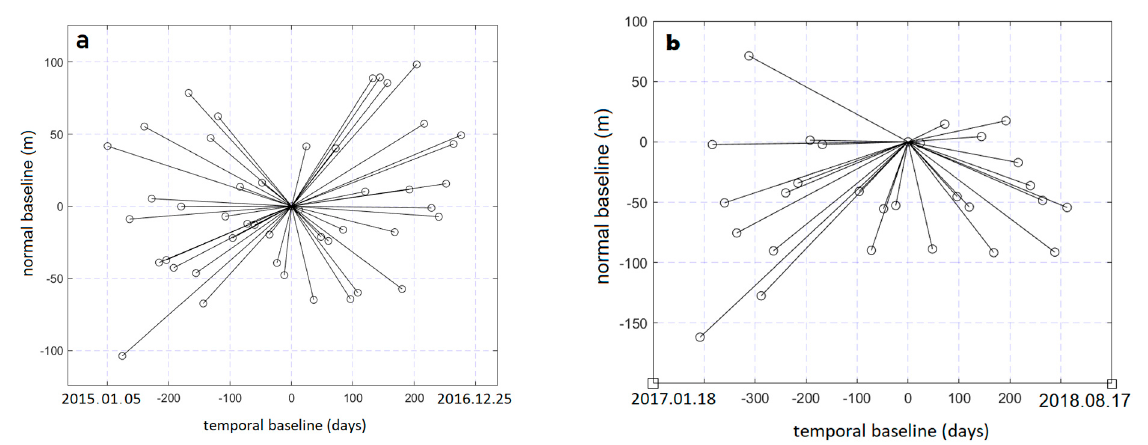
Figure 3. The perpendicular baseline graph for the ( a ) first and ( b ) second group data stack. The circles and the edges represent the images and interferograms, respectively.